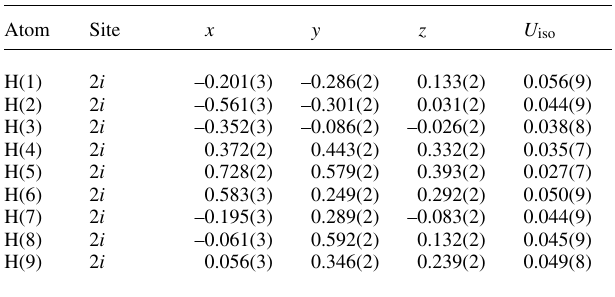
Table 2. Atomic coordinates and displacement parameters (in Å 2 )